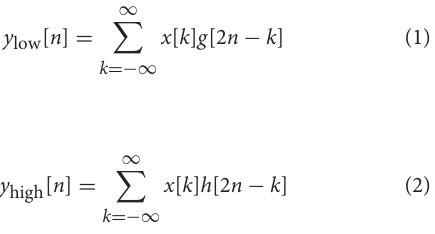
with high (detail) and low (approximation) frequencies (here wavenumbers) are analyzed independently. The approximate component is further transformed into sub-level detail and approximate signals which constitutes a multi-level decomposition (Figure 2) and reduces the dimensions of the input. The Approximation and Detail coefficients for each level can be calculated by using Equations (1) and